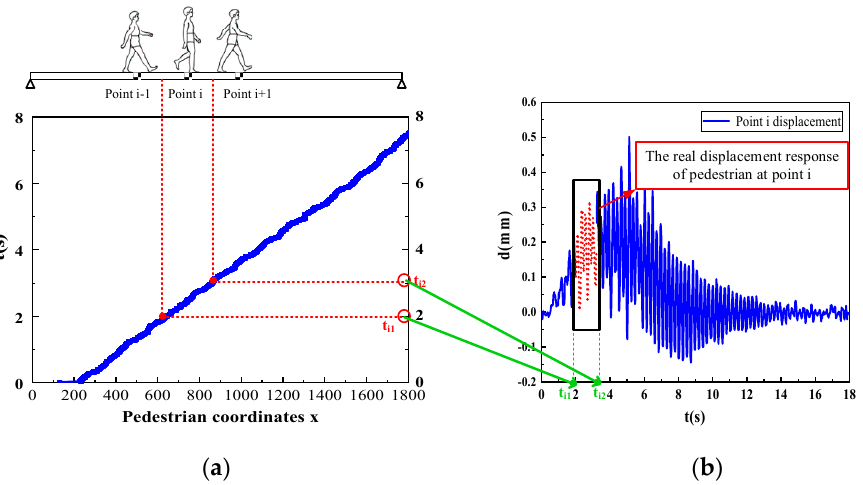
Figure 4. Global displacement extraction method. ( a ) Pedestrian position; ( b ) displacement response of point i .